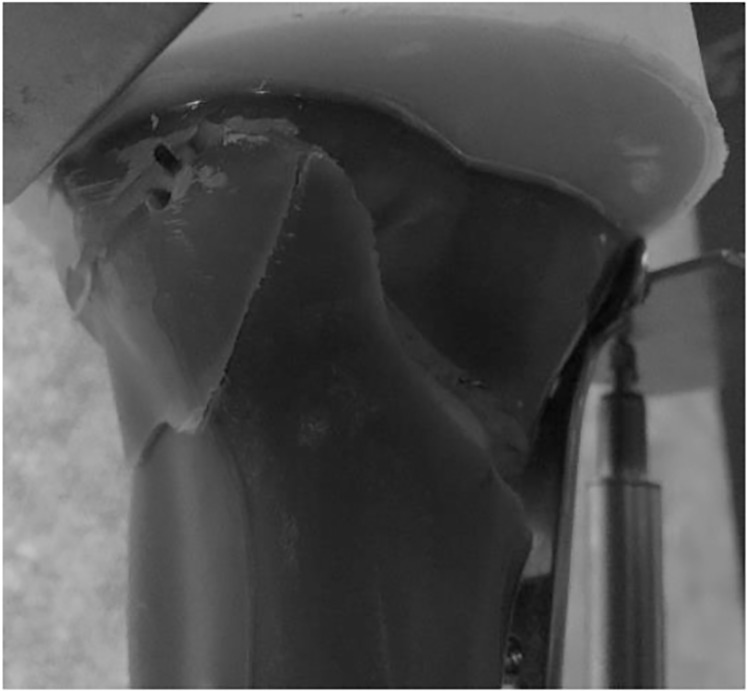
Example of lateral cortex fracture indicating failure of the construct.